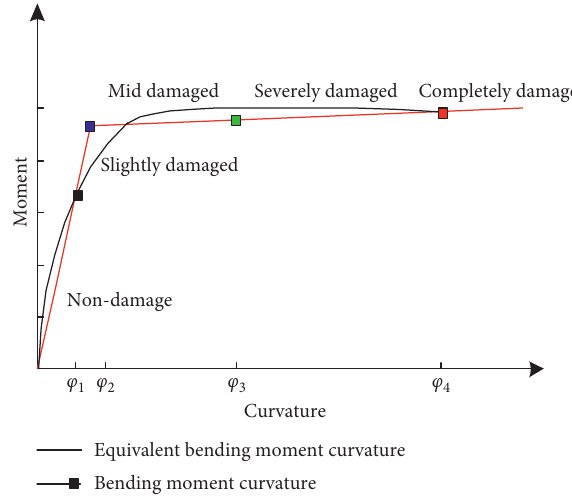
Figure 1: Schematic diagram of the damage state interval.